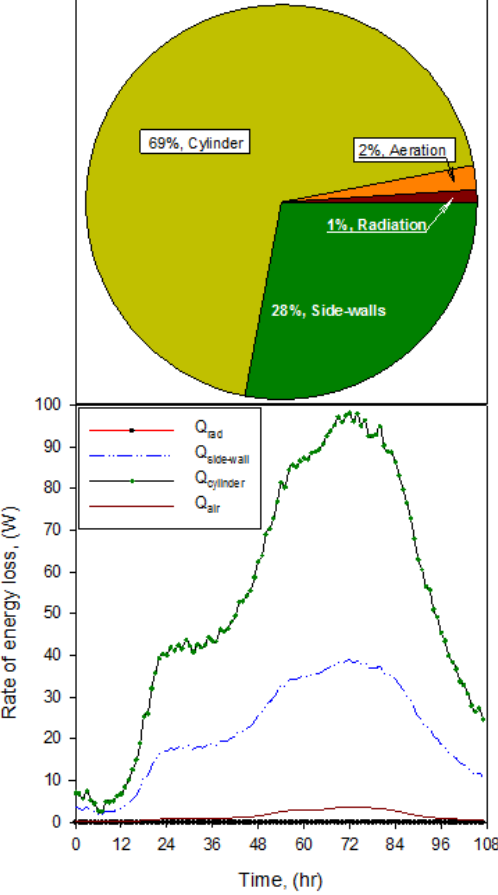
Figure 7. Energy-rate losses from inside to outside the bioreactor during the composting process via radiation, convection, and the exhausted air.